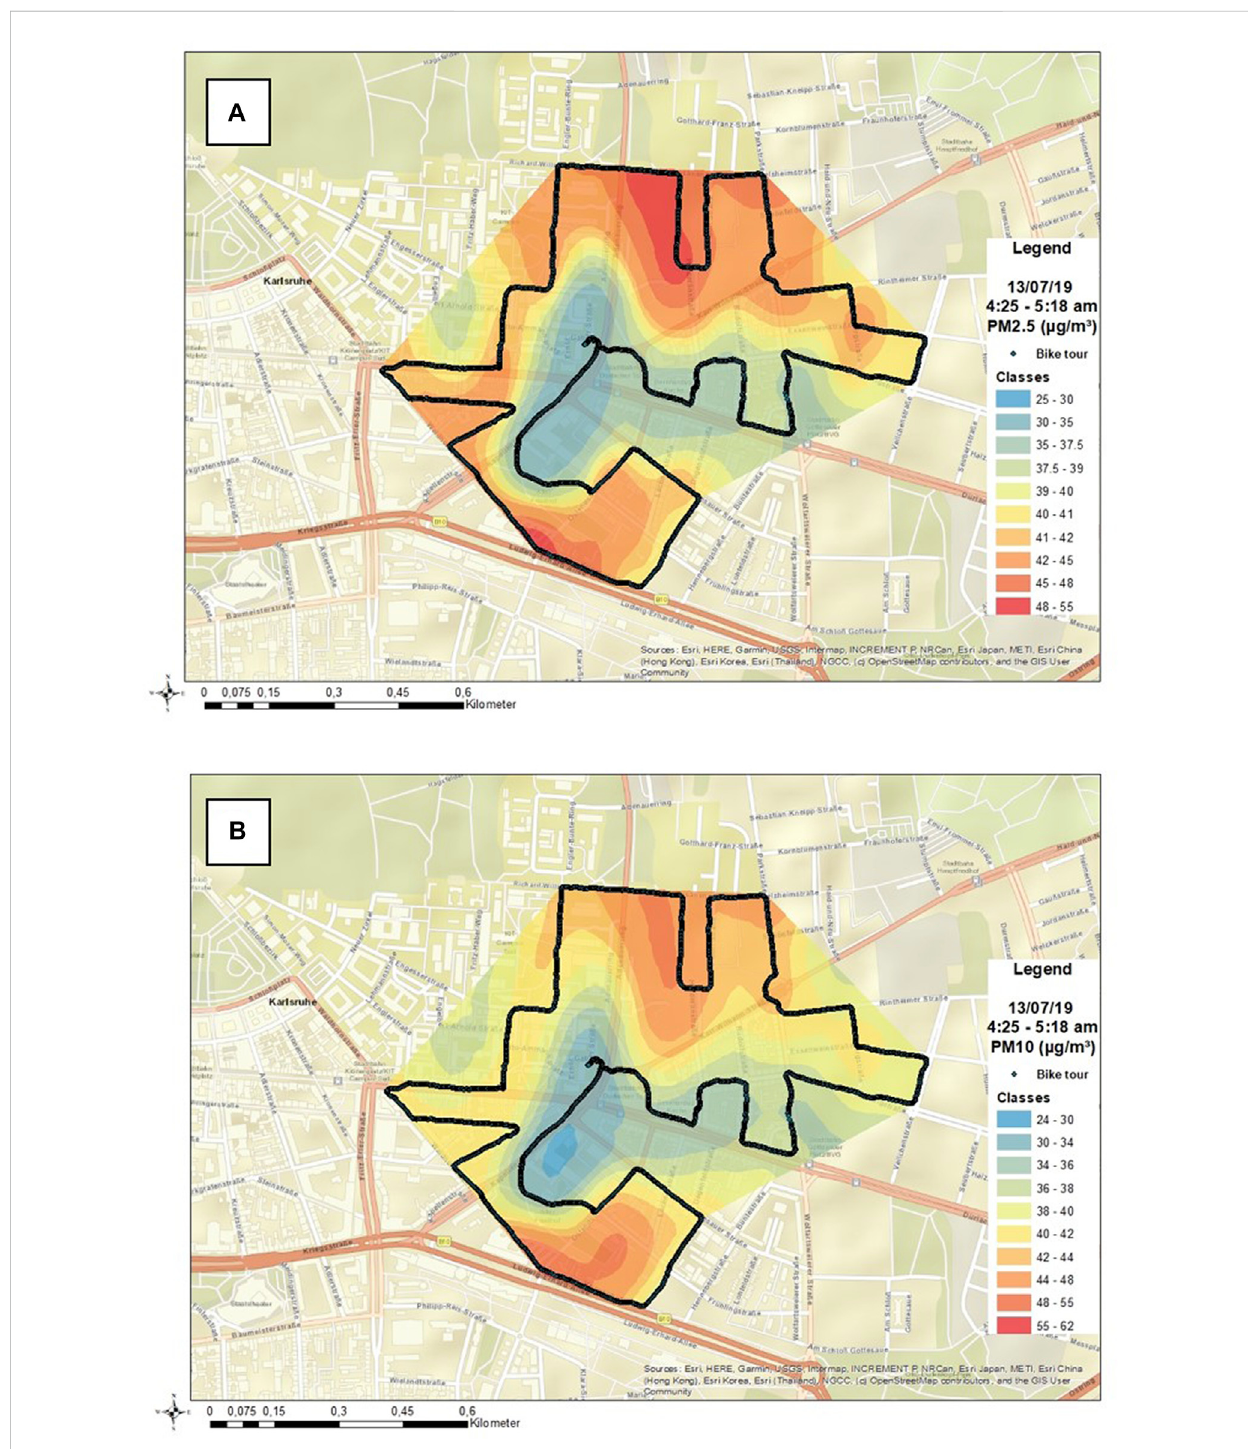
ARCGIS (version 10.7.1). In all cases, ordinary kriging was conducted. Gaussian, spherical, stable and hole effect variogram models nested with a nugget effect could be adapted to the patterns of the experimental variograms. These models show varying sills and ranges indicating the intervariability of the urban aerosol